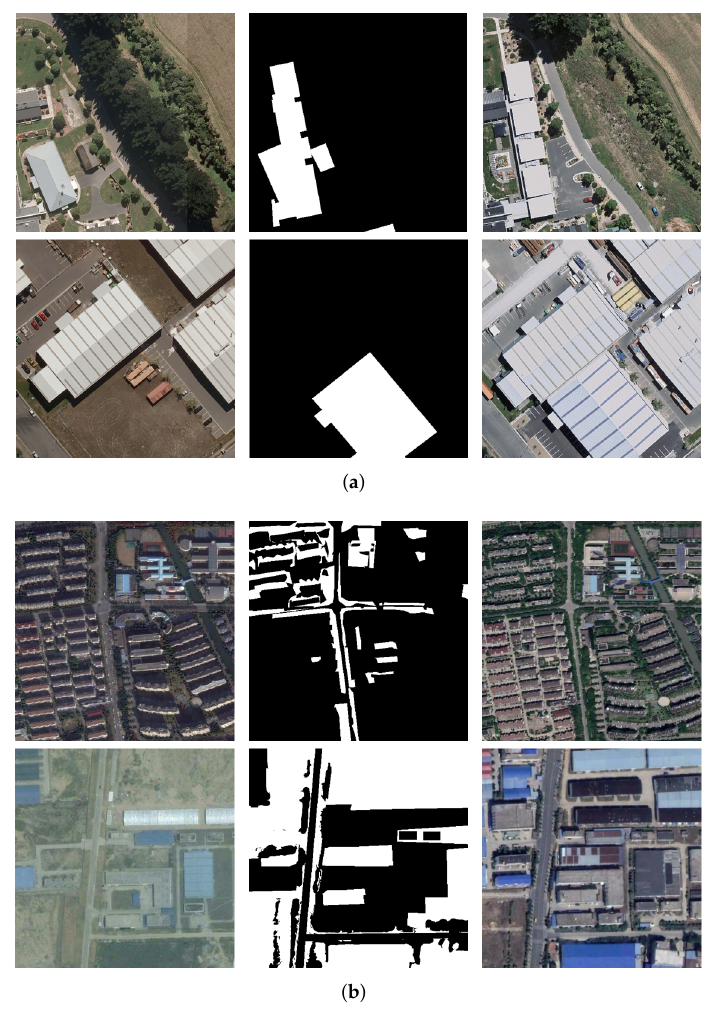
Figure 6. Visualizations of the two experimental datasets. ( a ) Bitemporal images (the first and the third column) and change masks (the second column) of the WHU dataset. ( b ) Bitemporal images (the first and the third column) and change masks (the second column) of the SECOND